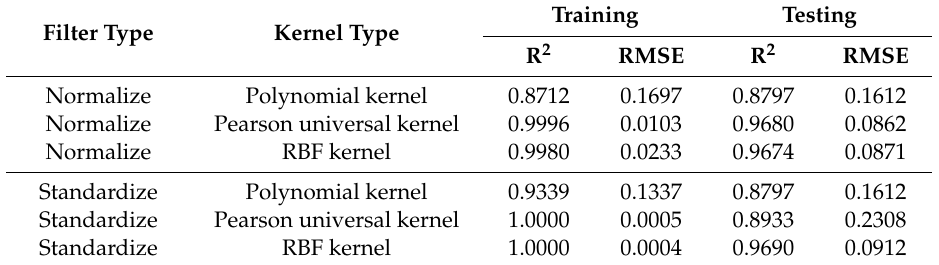
Table 11. Statistical results of drying kinetics of persimmon samples for SVM model using HAD